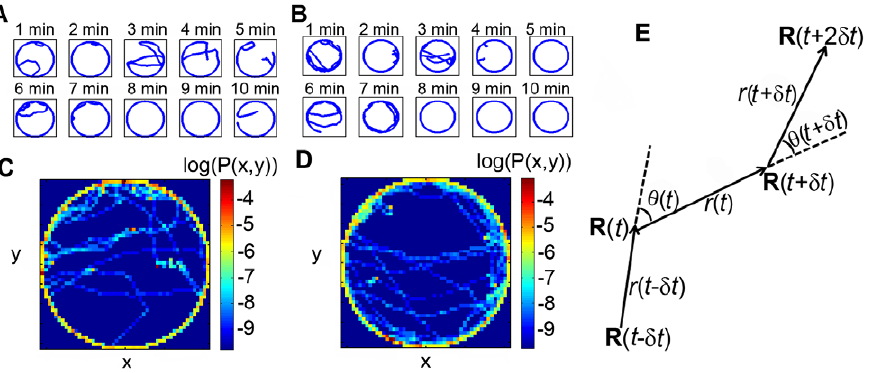
Figure 1. Position characteristics of a fly inside a circular arena of radius 4.2 cm. Two experiments, each of 10 minute duration broken into 1 minute intervals, are shown in A and B . The spatial density, P(x,y), of the fly in A and B are shown in C and D , respectively, in logarithmic scale. The density plots clearly indicate that the fly prefers the boundary and has no angular preference along the boundary. In panel E , we illustrate turn angle, h , and step size, r , in the two-component model. There are four consecutive locations of the fly at time t { d t , t , t z d t and t z 2 d t . Turn angle h ( t ) at time t is measured with respect to the direction of movement at the previous time step. The direction of movement at time t { d t is along the direction of vector R ( t z d t ) { R ( t ) . The step length r ( t ) at time t is given by DD R ( t z d t ) { R ( t ) DD .